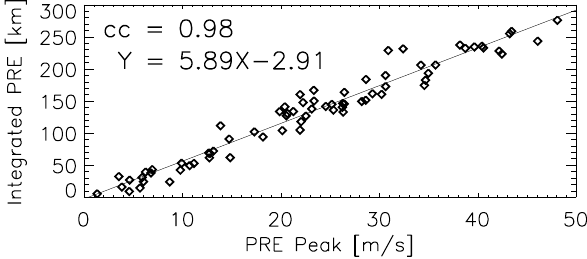
Fig. 2. The integrated plasma drift plotted over the peak plasma drift velocity during the same PRE period for all longitudes and seasons and for a solar flux level of F10.7 = 150. Corresponding correlation coefficient (cc) and regression line parameters are provided in the